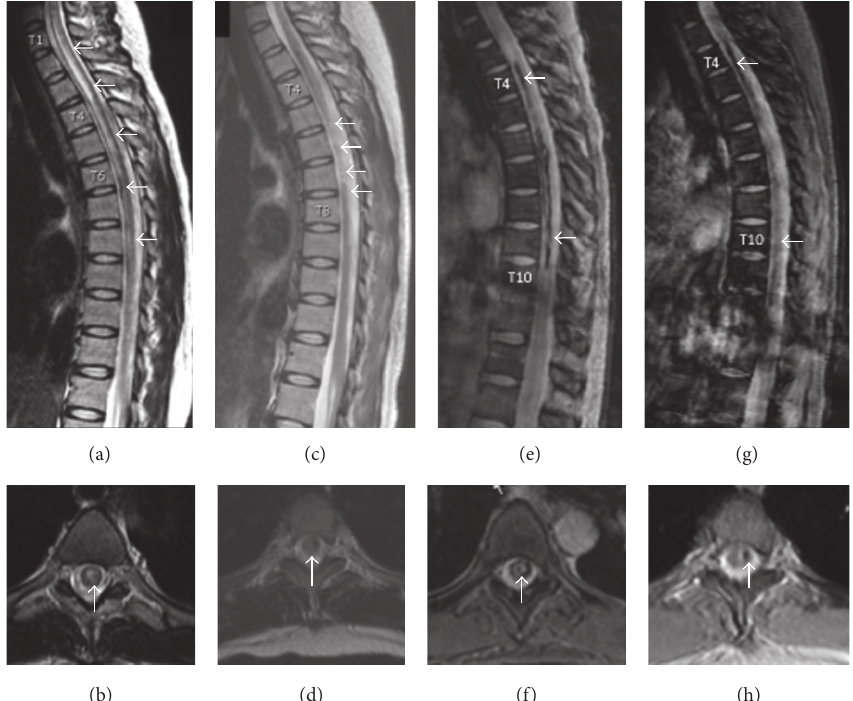
Figure 1: Cervical and thoracic MRI. At initial presentation, sagittal T2-weighted image (a) demonstrated extensive T2-signal abnormality from C6-C7 to T11-T12 involving the central gray matter (b). Sagittal gradient echo (GRE) showed decreased GRE signal extending from T3-T4 to T9-T10 (e, f). At three-month follow-up, the cord signal on T2-weighted imaging was normal (d) with volume loss within the cord from T3-T4 to T7-T8 (c, arrows). The long regions of decreased GRE signal within the central aspect of the cord compatible with hemosiderin deposition persisted (g, h). There was poorly defined abnormal enhancement within the cord behind the T5 and T6 vertebral bodies (not